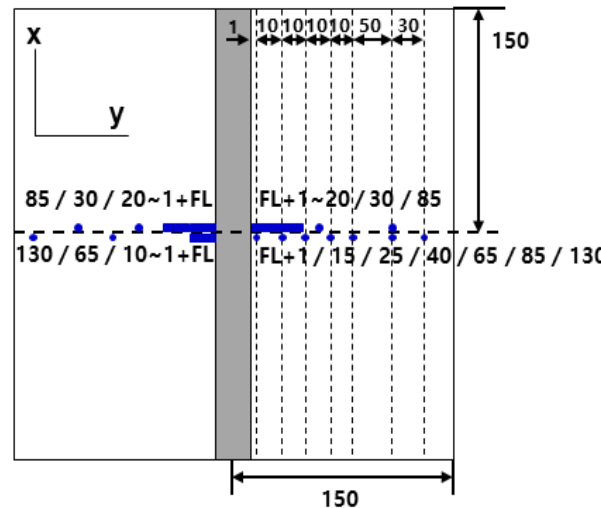
Figure 4. Attachment position strain gauges to the specimens.